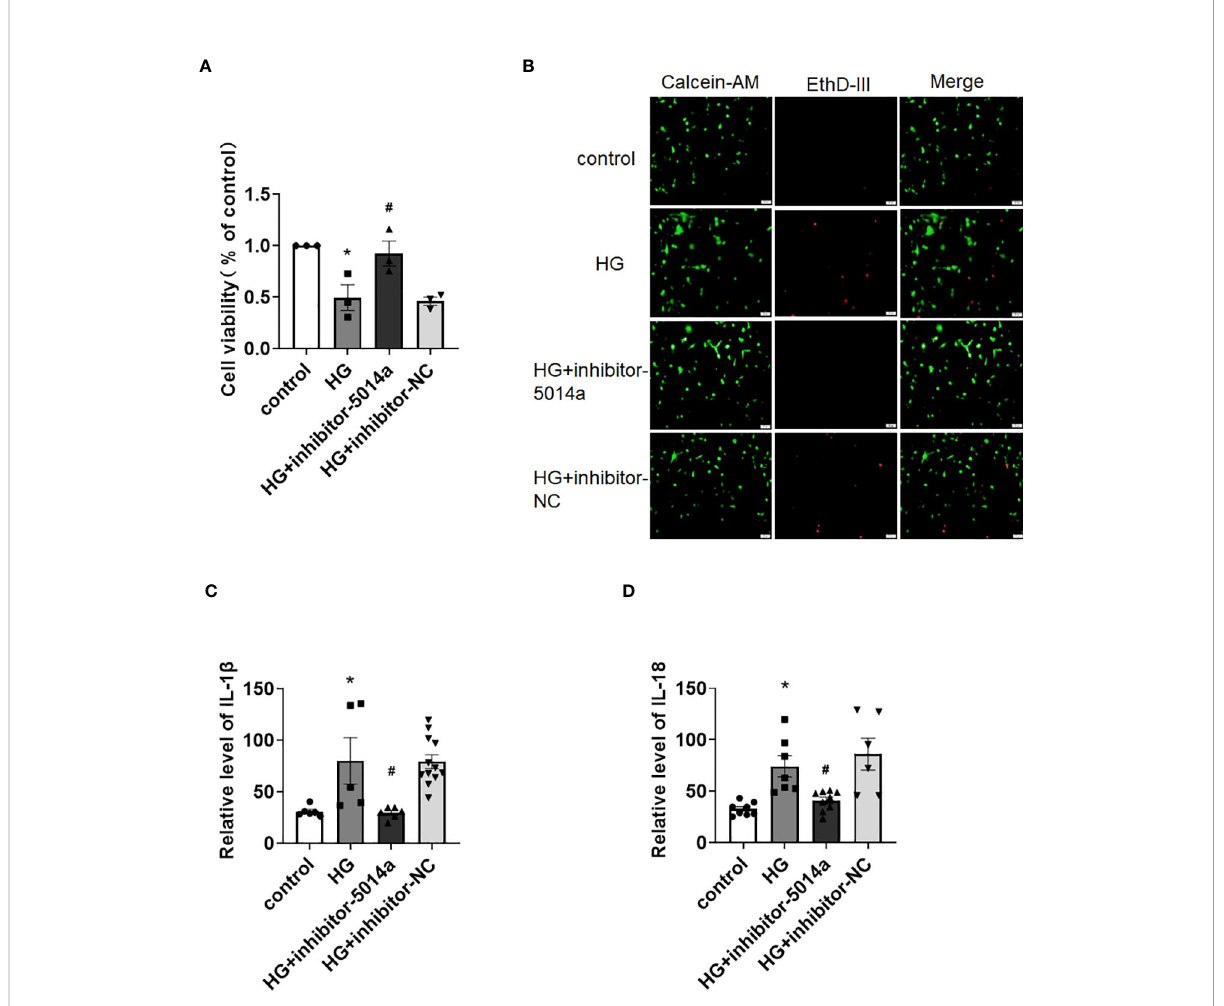
FIGURE 4 Inhibition of tRF-5014a improved cardiomyocyte injury in HG-treated primary cardiomyocytes. (A) The cell viability of different groups was detected by CCK-8 assay. n = 3 in each group. * P < 0.05 versus control, # p < 0.05 versus HG. (B) The live (green) and death (red) cells of different groups were labeled with calcein-AM and EthD-III. The results showed that downregulation of tRF-5014a signi fi cantly blunted the increase in cell death induced by HG treatment in primary cardiomyocytes. (C, D) The levels of the proin fl ammatory cytokines IL-1 b (C) and IL- 18 (D) were detected by ELISA assay. n = 5-12 in each group. * P < 0.05 versus control, # p < 0.05 versus HG. HG, high glucose, inhibitor-5014a: tRF-5014a inhibitor, inhibitor-NC: tRF-5014a inhibitor negative